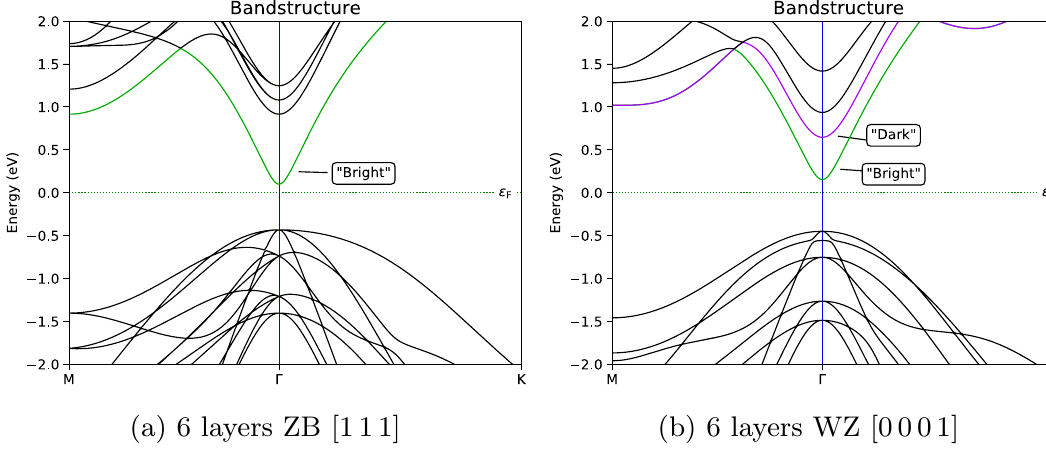
Figure 2. Band structures of InP phases in a hexagonal unit cell. Band parameter